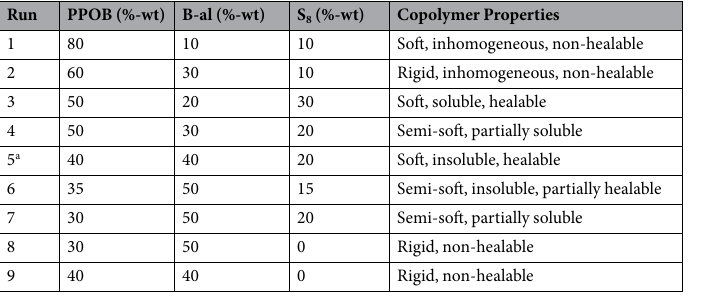
Table 2. PPOB, B-al and S 8 feed ratios for the preparation of PPOB x -B-al y -S z copolymers. a These mixing ratios yielded insoluble and self-healable